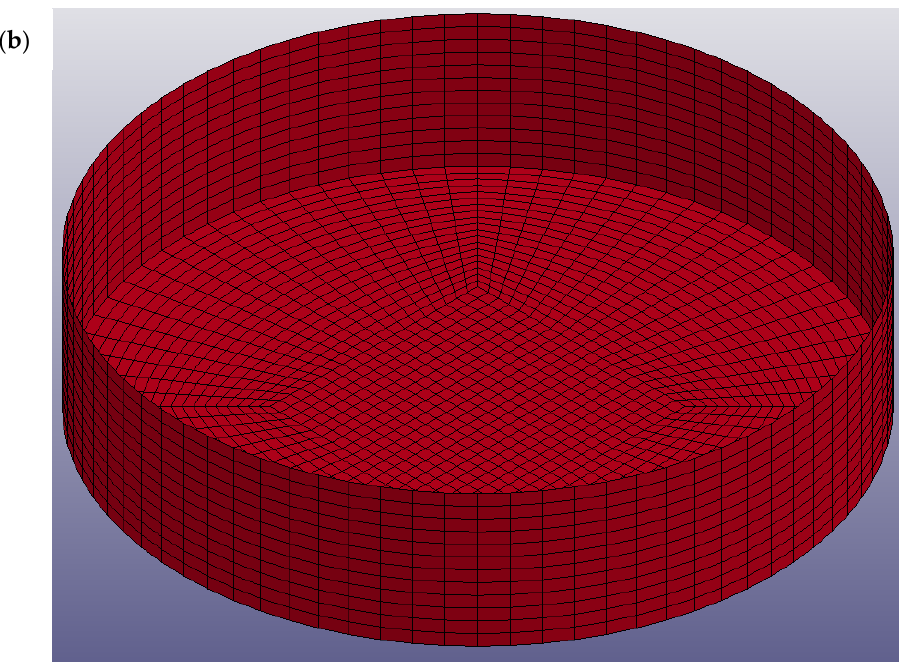
Figure 1. ( a ) Proposed model of thin-walled storage tank. ( b ) Meshing details .